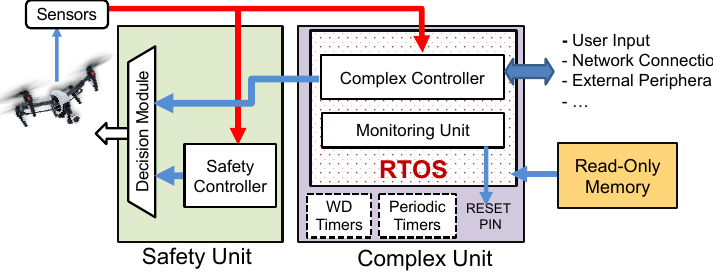
Figure 6. The ReSecure framework [32]: Safety unit is the bare-metal verified component and complex unit is not verified. The decision module switches between the controllers to provide overall system